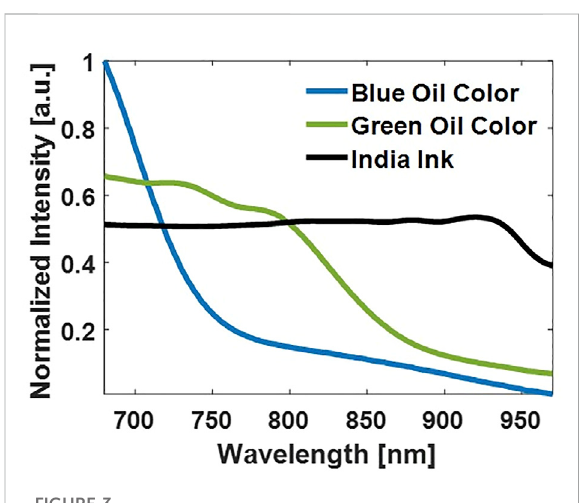
FIGURE 3 Absorption spectra of the dyes used within the vessel- mimicking phantoms measured by the NIRS